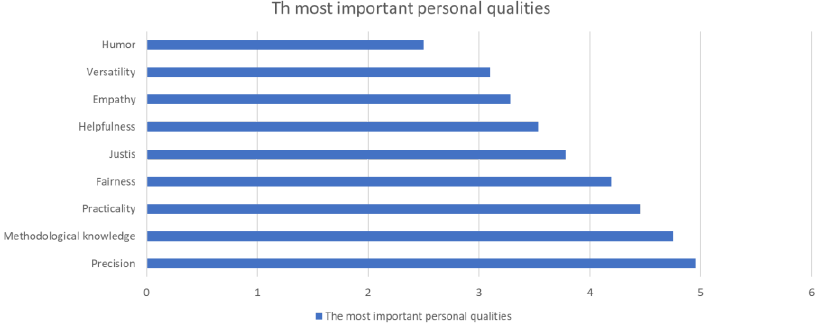
Fig. 2. The most important personal qualities according the teacher